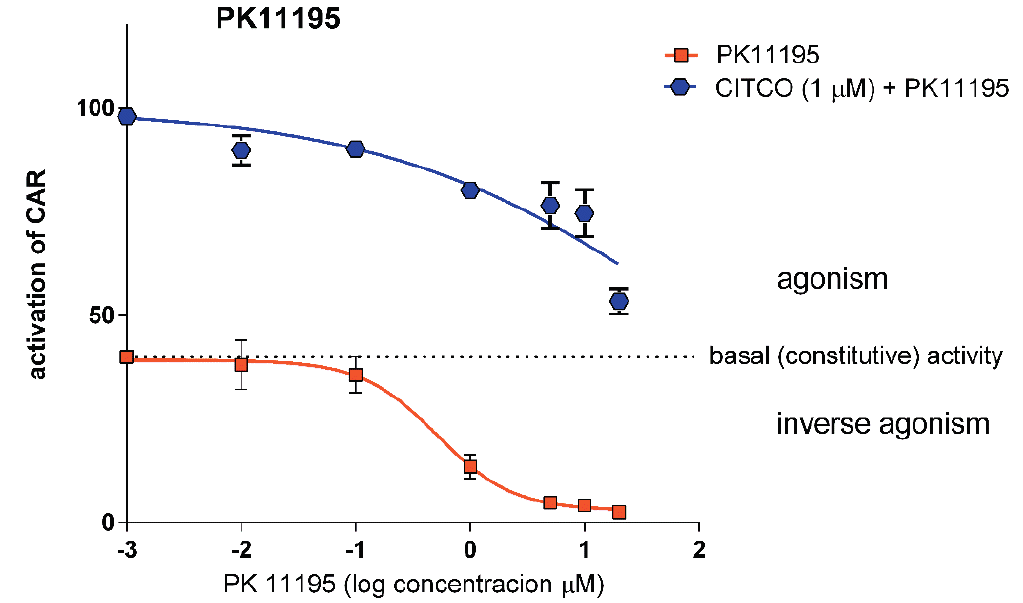
Figure 3. Effect of PK11195 on CAR LBD activity in the TR-FRET LanthaScreen TM CAR Coactivator Assay. PK11195 in a serial dilution was tested in inverse agonistic or antagonistic modes together with the prototype CAR agonist CITCO (1 μ M concentration) using the TR-FRET assay. Data are presented as the relative activation to background activity (no CAR LBD in the reaction mixture, set to 0%) and to the effect of CITCO (1 μ M) set as 100% activation. The dotted line represents the constitutive activity of CAR LBD (vehicle-treated samples). Data are presented as the means and S.D. from three independent experiments ( n = 3). Dose response curves were fitted using a sigmoidal dose response equation with a variable slope employing the software GraphPad PRISM ver.